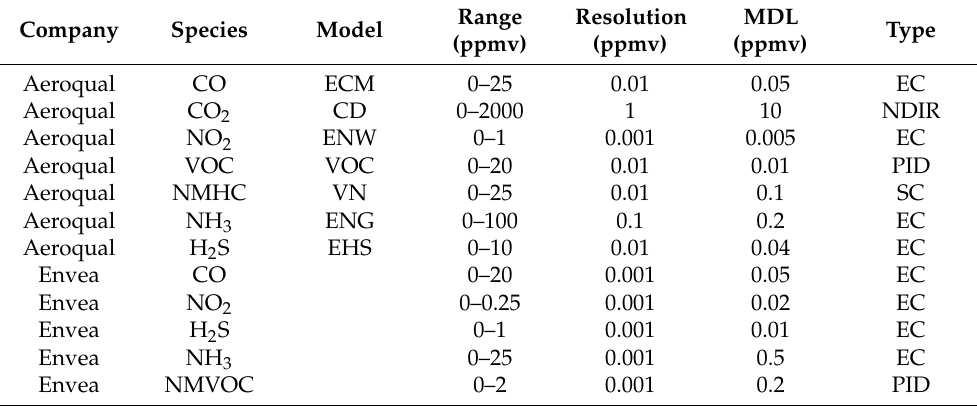
Table 1. Summary of manufacturers’ performance specifications for sensors tested in this